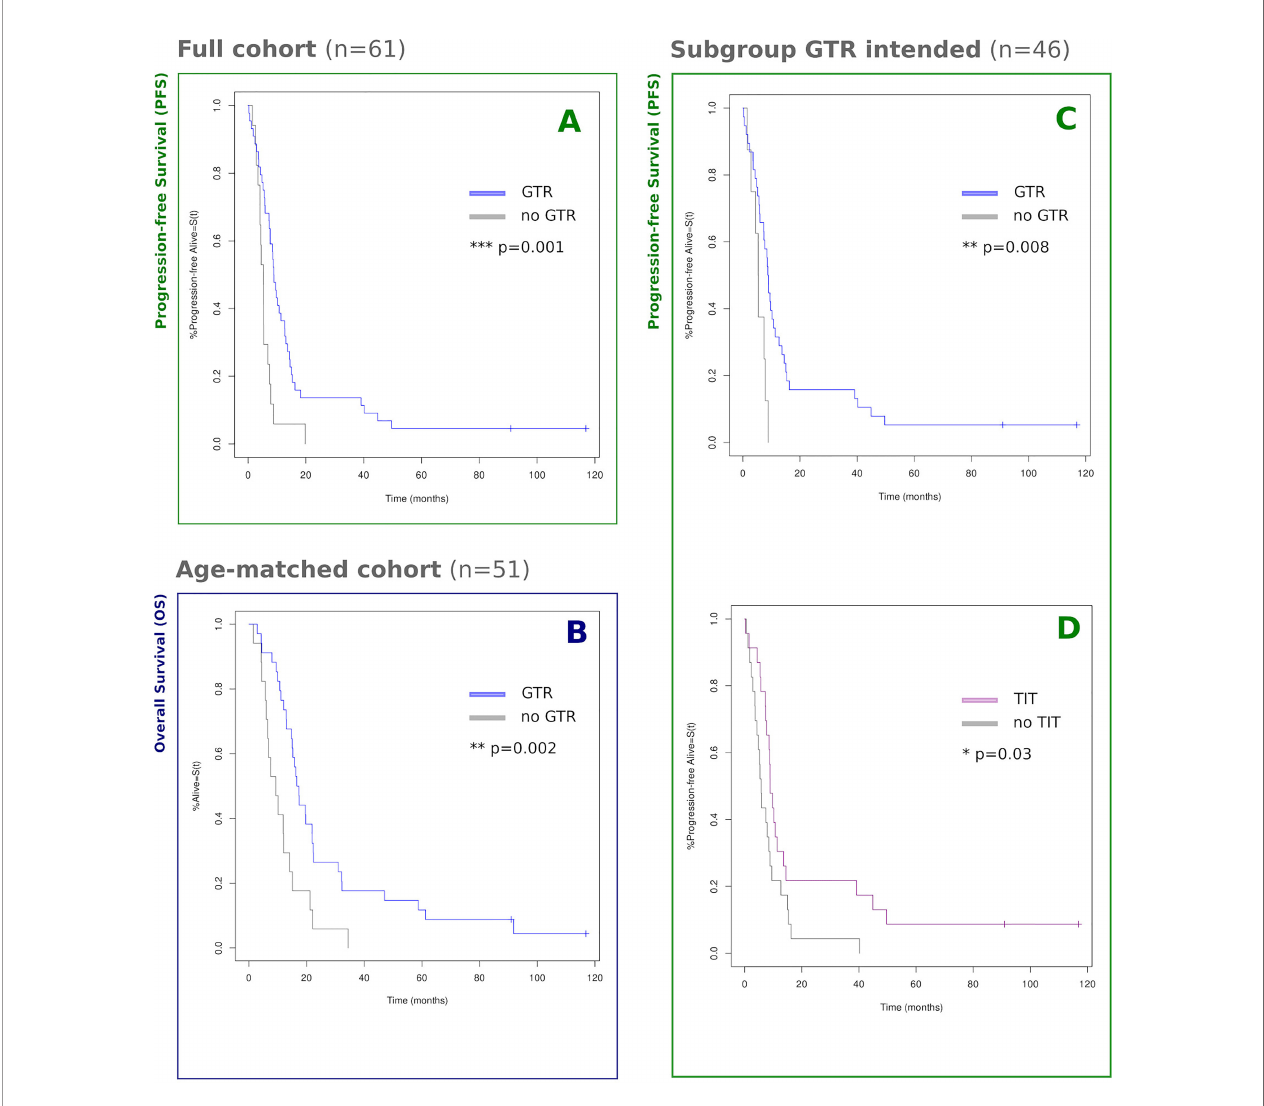
FIGURE 5 | Kaplan – Meier survival curves by group. Estimated survival proportions according to Kaplan – Meier statistics are displayed, grouped by GTR/TIT. Censoring events are indicated by vertical ‘ ticks ’ . (A) Full cohort of n = 61, GTR vs. no GTR: 8.9 vs. 5.3 months [ c ² = 10.6; p = 0.001]; (B) PSM age-paired cohort of n = 51, GTR vs. no GTR: 17.0 vs. 9.3 months [ c ² = 9.7; p = 0.002]; (C, D) Subgroup of n = 46 patients a-priori eligible for GTR, pairwise balanced for PTV and insula-overlap using PSM. (C) GTR vs. no GTR: 8.8 vs 5.5 months [chi2 = 7.1; p = 0.008] ("p = " is missing); (D) TIT vs. no TIT: 8.9 vs. 5.8 months [ c ² = 4.7; p = 0.030]. For an overview of PSM raw data, cf. Supplementary Tables S3 (B) and S2 (C , D) . *p <0.05; **p <0.01; ***p <0.001.